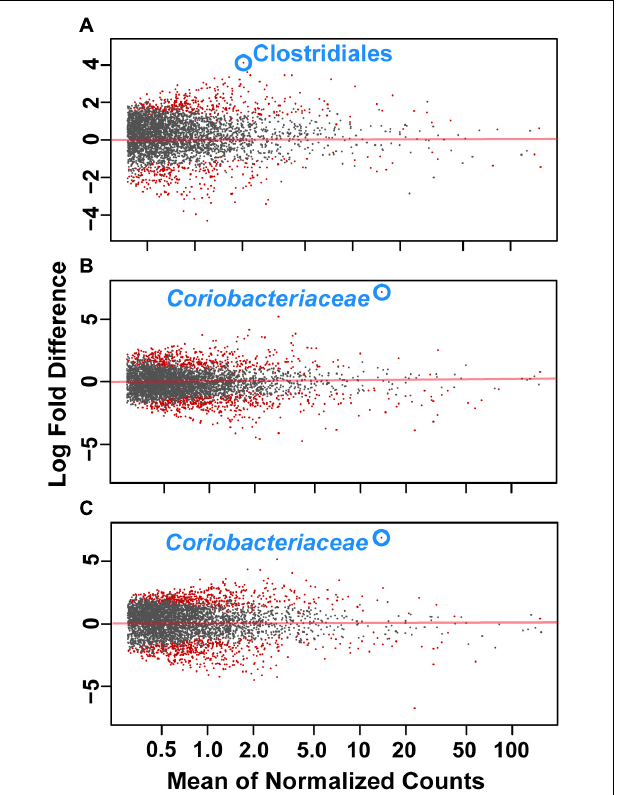
FIGURE 4 | Log2 fold-difference in OTU abundance from samples comparing (A) freestall to drylot (B) pasture to freestall and (C) pasture to drylot housing. Significantly changed OTU abundance are shown in red determined by an adjusted p ≤ 0.01. The most significantly changed OTU is circled and labeled with assigned taxonomy. The family Coriobacteriaceae showed the most significant change on pasture farms compared to both non-pasture systems while the order Clostridiales was most significantly changed in freestall farms compared to